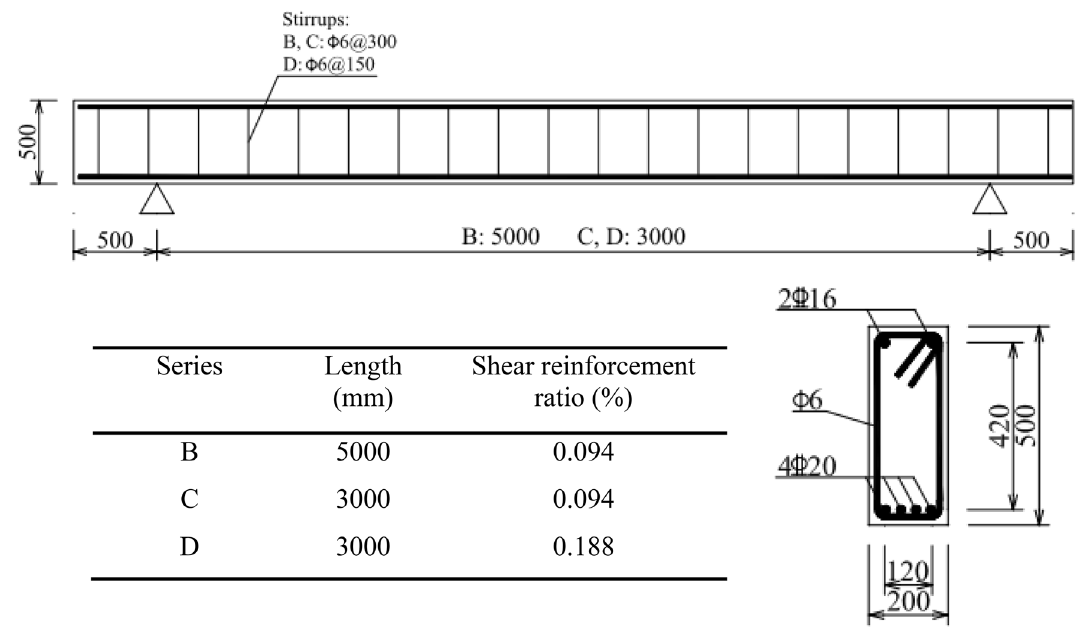
Fig. 2 Specimens’